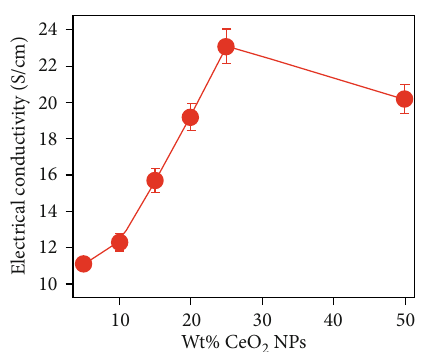
Figure 3: Electrical conductivity of CeO with di ff erent wt% of CeO